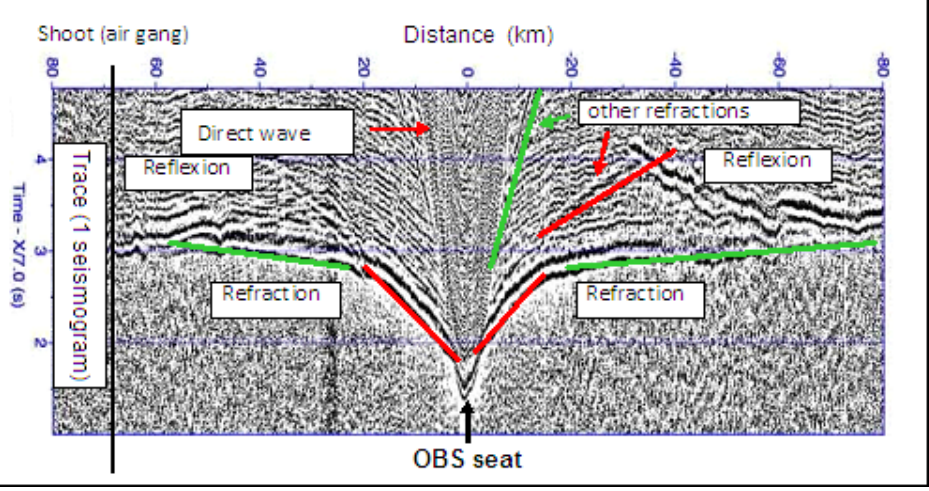
Figure 3. Seismic section from data of a single component, acquired by a single OBS designed by SARTI-UPC in a controlled source seismic experiment. We identify the direct wave, the reflections and refractions of an acoustic